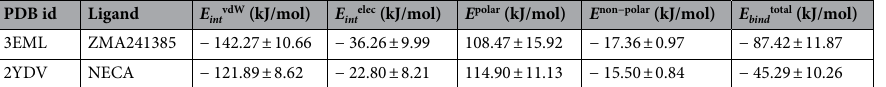
Table 3. Ligand-receptor binding energy ( E bind total ) and its components, the vdW interaction energy ( E int vdW ), the electrostatic interaction energy ( E int elec ), the polar solvation energy ( E polar ) and, the non-polar solvation energy ( E non−polar ). The MMPBSA-based calculations were carried out on the last 10 ns of the 100 ns conventional MD simulations performed prior to the SMD simulations. The E non−polar was estimated by using the non-polar solvation model of solvent accessible surface area (SASA). The contributions from the net non-bonded interaction energies ( E int net ), those were calculated in vacuum, to the binding energies were decomposed into E int vdW and E int elec